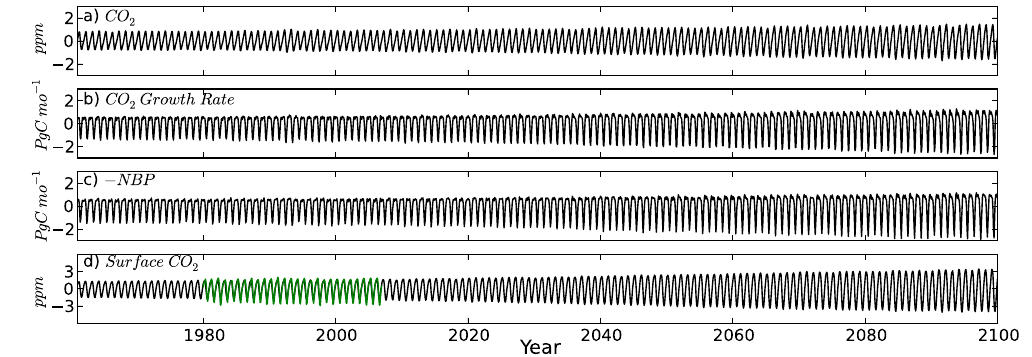
Figure 1. Nine-model (excluding IPSL) averaged monthly detrended: (a) global mean CO 2 (ppm, column average); (b) global mean CO 2 growth rate (PgCmonth − 1 , using a conversion factor of 1ppm = 2 . 12PgCmonth − 1 ); and (c) global total − NBP (PgCmonth − 1 ) from 1961 to 2099. (d) Presents eight-model (excluding IPSL and INM) averaged monthly detrended global mean CO 2 (ppm) at lowest model level and ESRL’s global mean detrended surface CO 2 observation (shown in